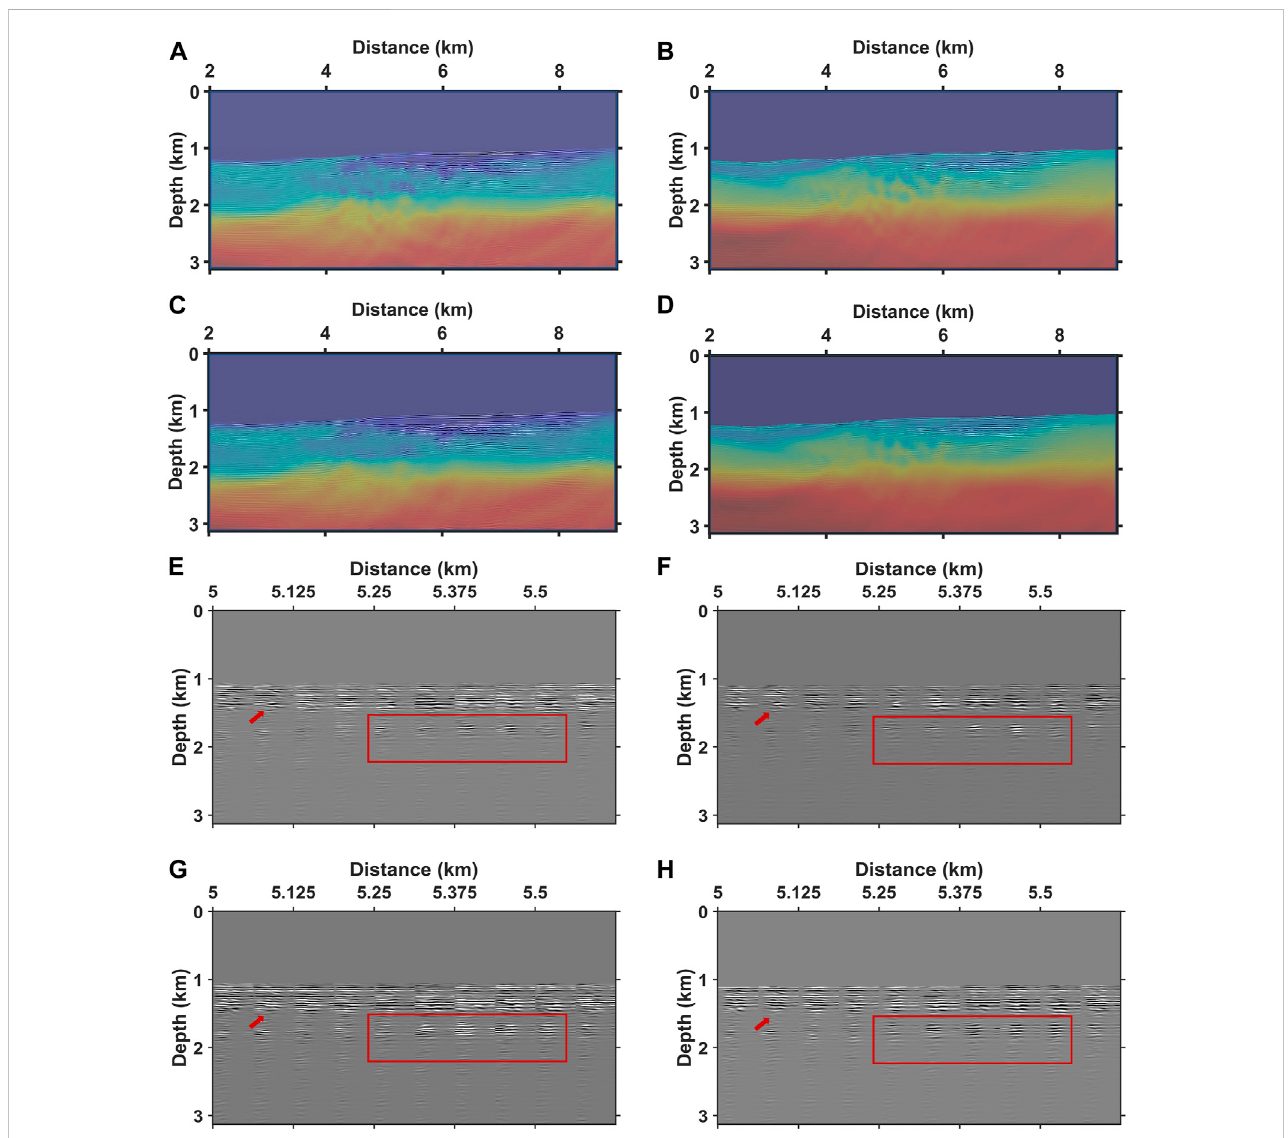
The images with corresponding velocity models overlay. P-wave velocity of AEFWI for OBS data (A) , S-wave velocity of AEFWI for OBS data (B) , P-wave velocity of J-AEFWI (C) and S-wave velocity of J-AEFWI (D) . The ADCIGs of (E) P-wave velocity of AEFWI for OBS data, (F) S-wave velocity of AEFWI for OBS data, (G) P-wave velocity of J-AEFWI, and (H) S-wave velocity of J-AEFWI. The areas indicated by arrows and rectangles show improvements for